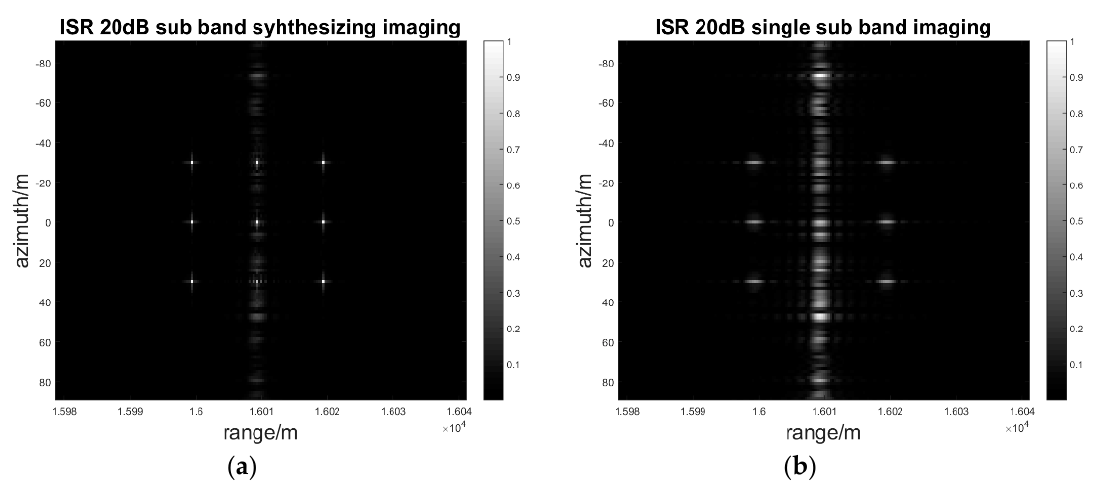
Figure 13. ISR 20 dB sub-band synthesis and single sub-band imaging result: ( a ) Sub-band synthesis of a two-dimensional gray image; ( b ) Single sub-band of a two-dimensional gray image.